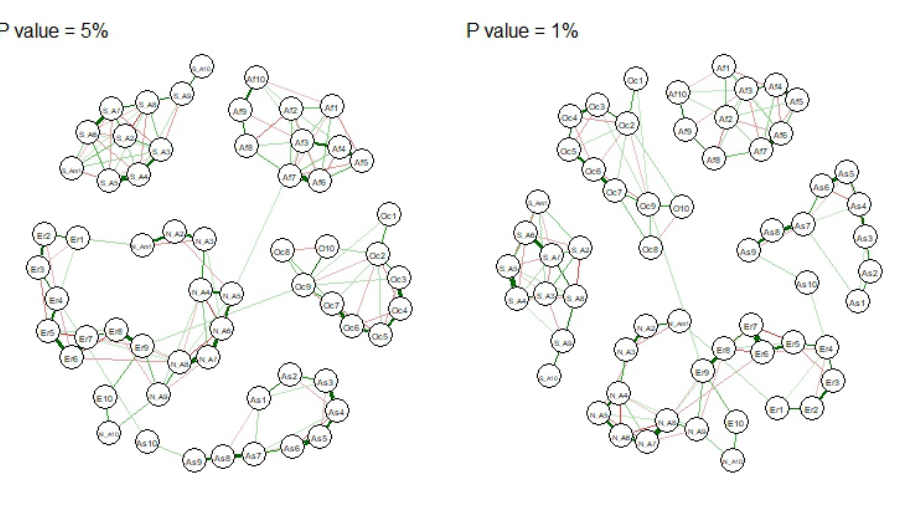
Figure 3. Regularized partial correlation networks (without edges that are not significant).